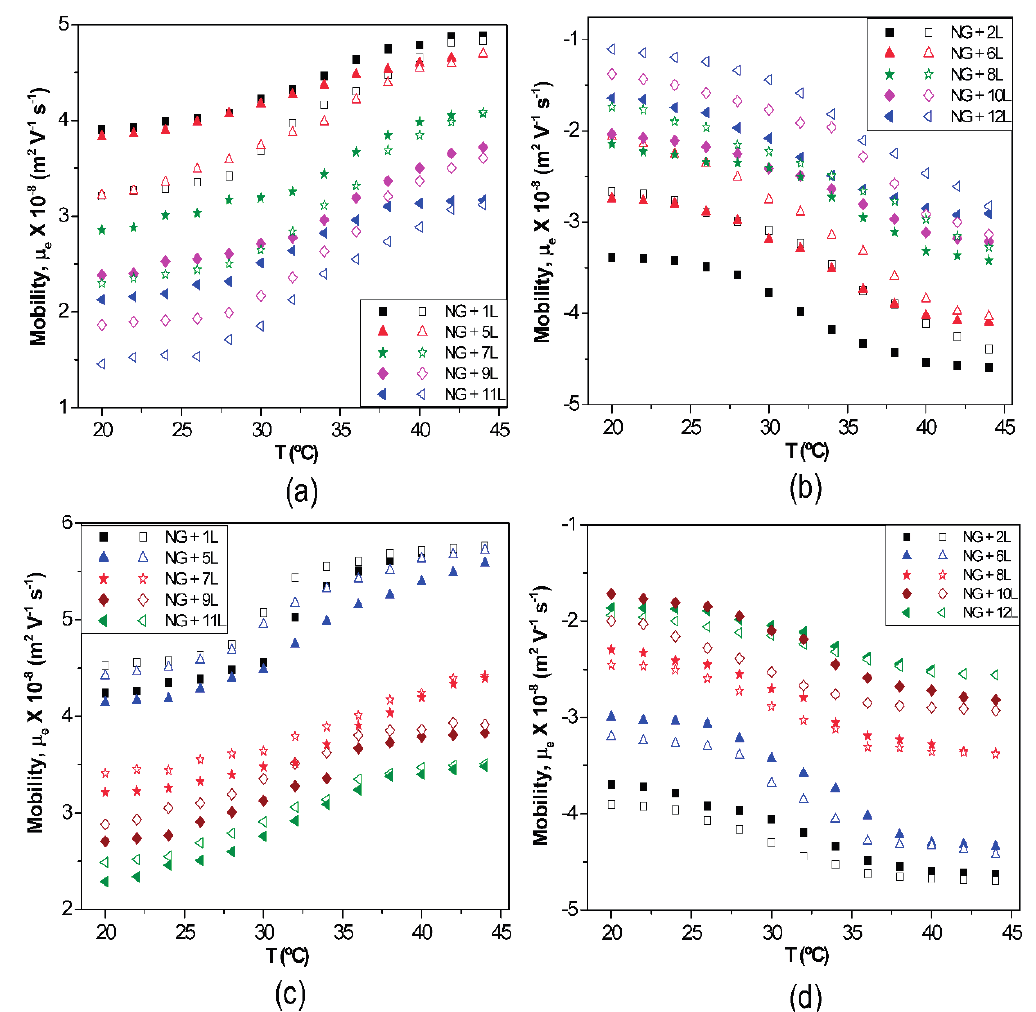
Figure 6. Electrophoretic mobility μ e vs. temperature for different biopolymer-terminated PNIPAM- co -MAA: ( a ) PLL; ( b ) PGA; ( c ) CHIT and ( d ) DEXS. Reproduced with permission from [8], copyright 2010,